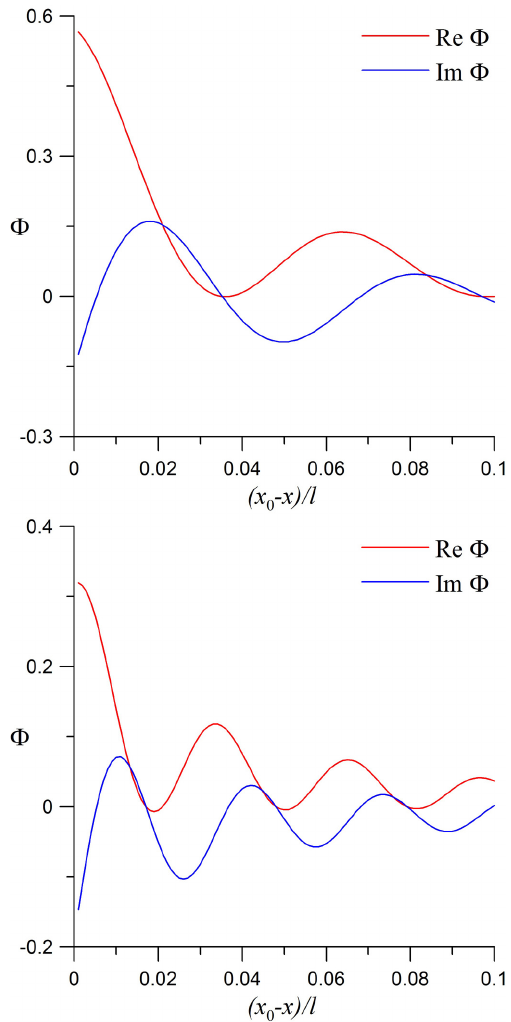
Fig. 2. Spatial structure of the wave at two times: (cid:127) 0 (t − t 0 ) = 100 (top panel) and (cid:127) 0 (t − t 0 ) = 200 (bottom panel).